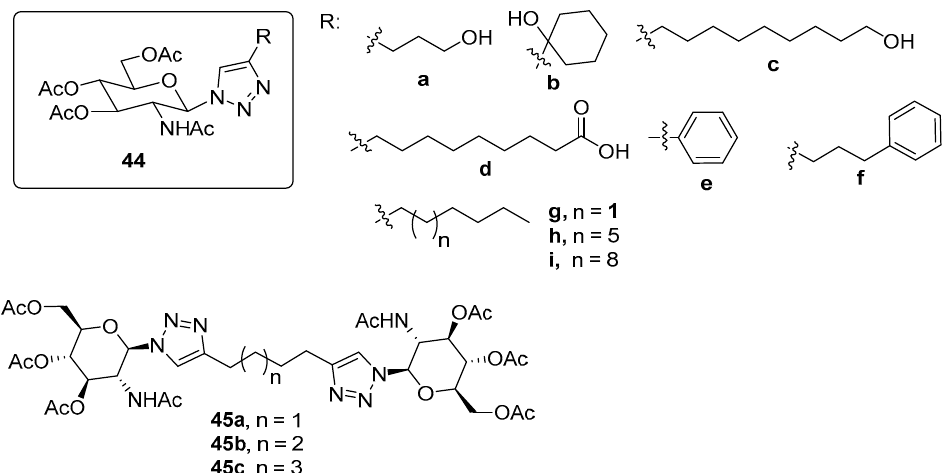
Figure 31. D-glucosamine triazole derivatives synthesized by the copper (I) catalyzed azide alkyne cycloaddition reaction [36], n represents the number of CH 2 unit.